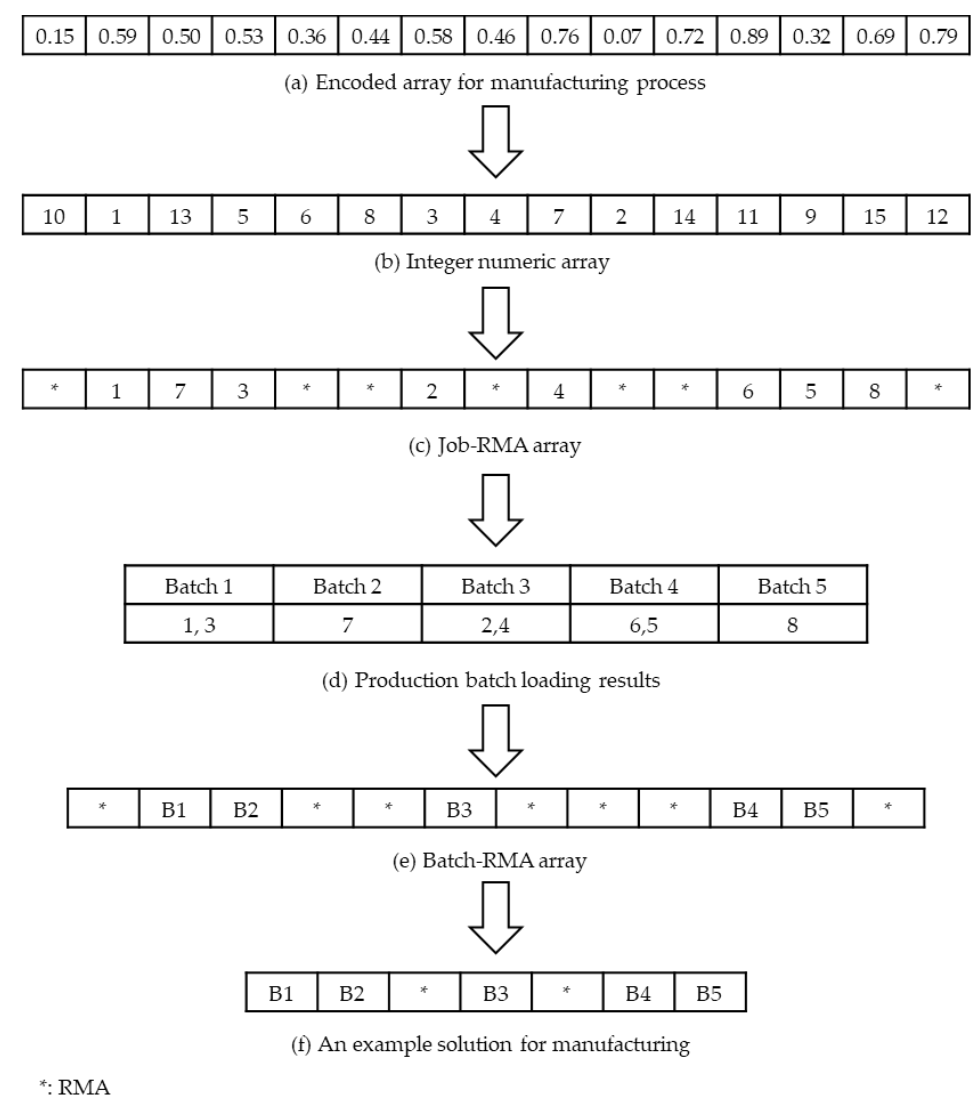
Figure 2. An example of decoding procedure for manufacturing.